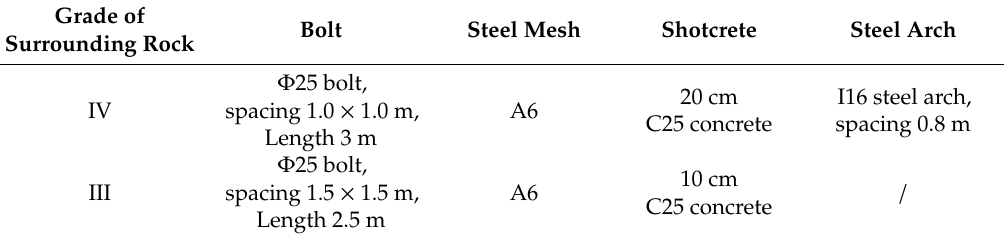
Table 3. Initial support parameters of